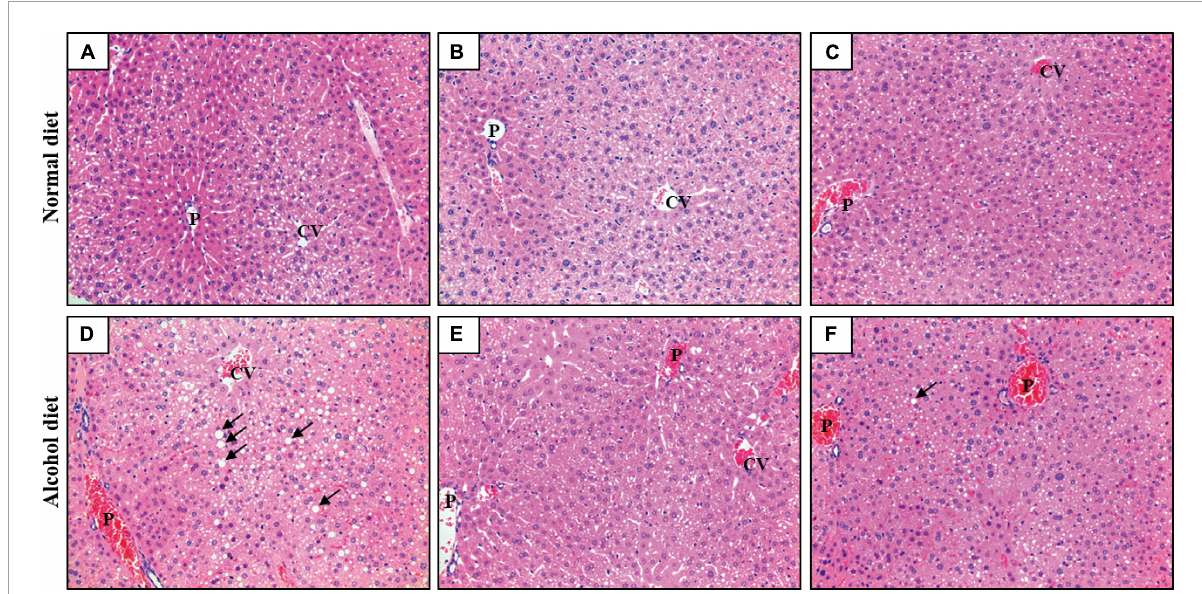
FIGURE3 Hematoxylin and eosin staining of liver sections ( × 200). (A) NC, normal diet group; (B) NL, normal diet and Lactiplantibacillus ( Lp .) plantarum DSR J266 + Levilactobacillus ( Lv .) brevis DSR J266 group; (C) NG, normal diet and Lacticaseibacillus ( Lb .) rhamnosus GG group; (D) AC, alcohol diet group; (E) AL, alcohol diet and Lp . plantarum DSR J266 + Lv . brevis DSR J301 group; (F) AG, alcohol diet and Lb. rhamnosus GG group. Lipid droplets are indicated using black arrows. CV, central vein; P, portal